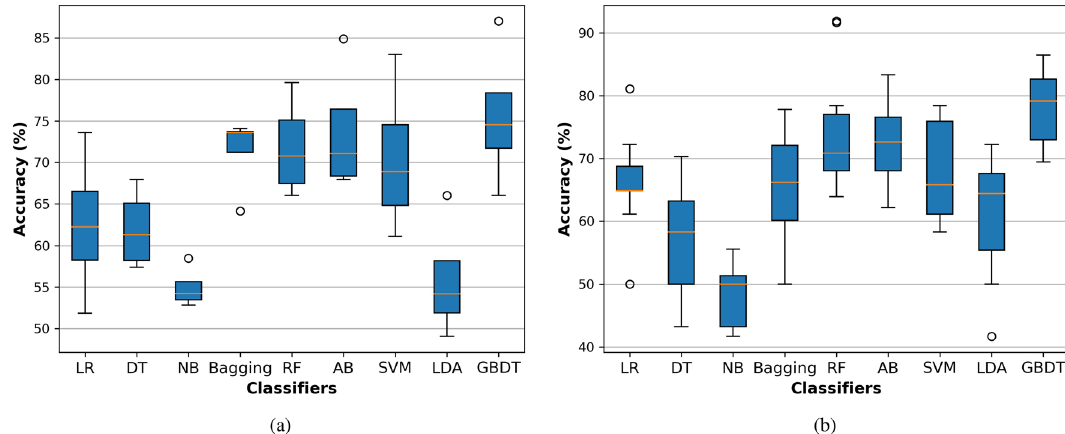
Figure 6. The accuracy box for the proposed system based on the GBDT compared with state-of-the-art classifiers on the lncRNA dataset with ( a ) 4-fold and ( b ) 10-fold cross-validation techniques.